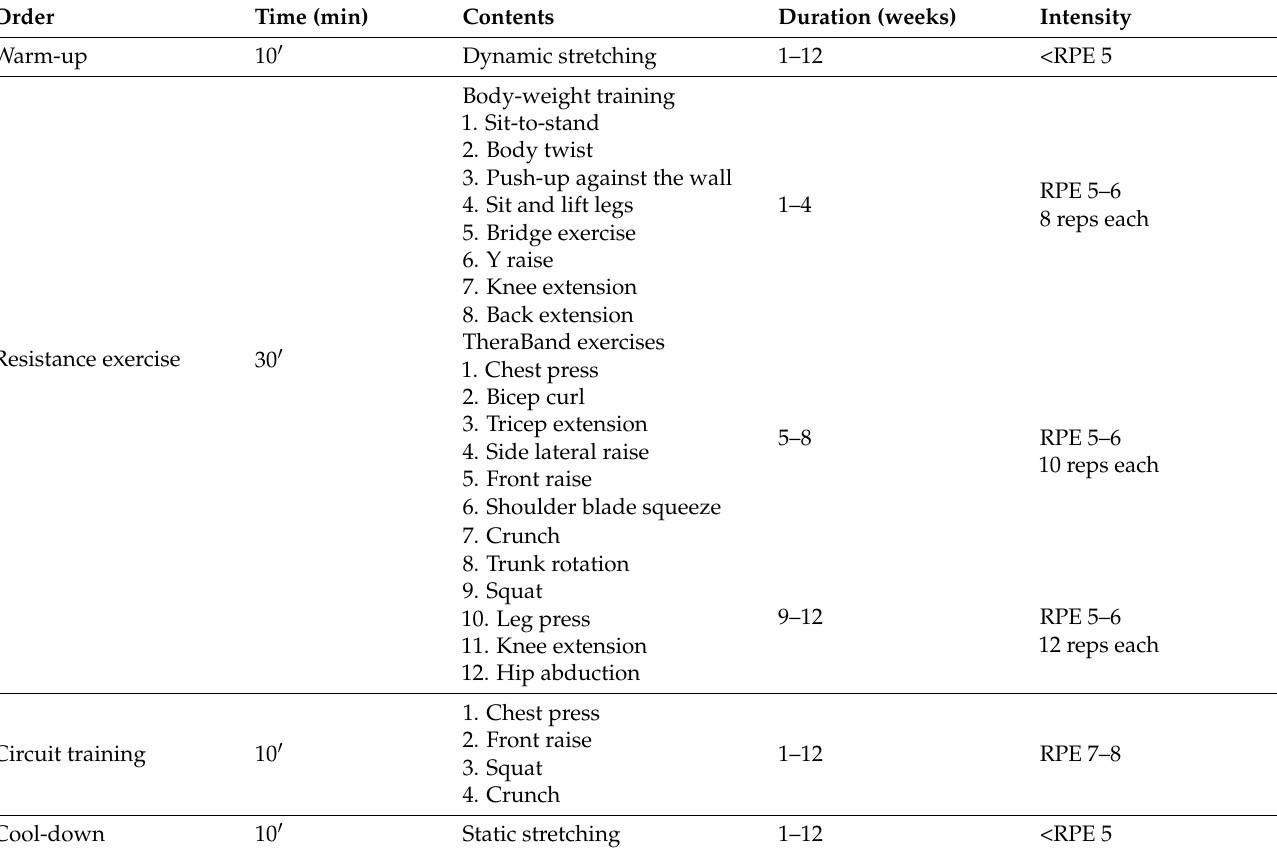
Table 1. Exercise training program for 12 weeks (3